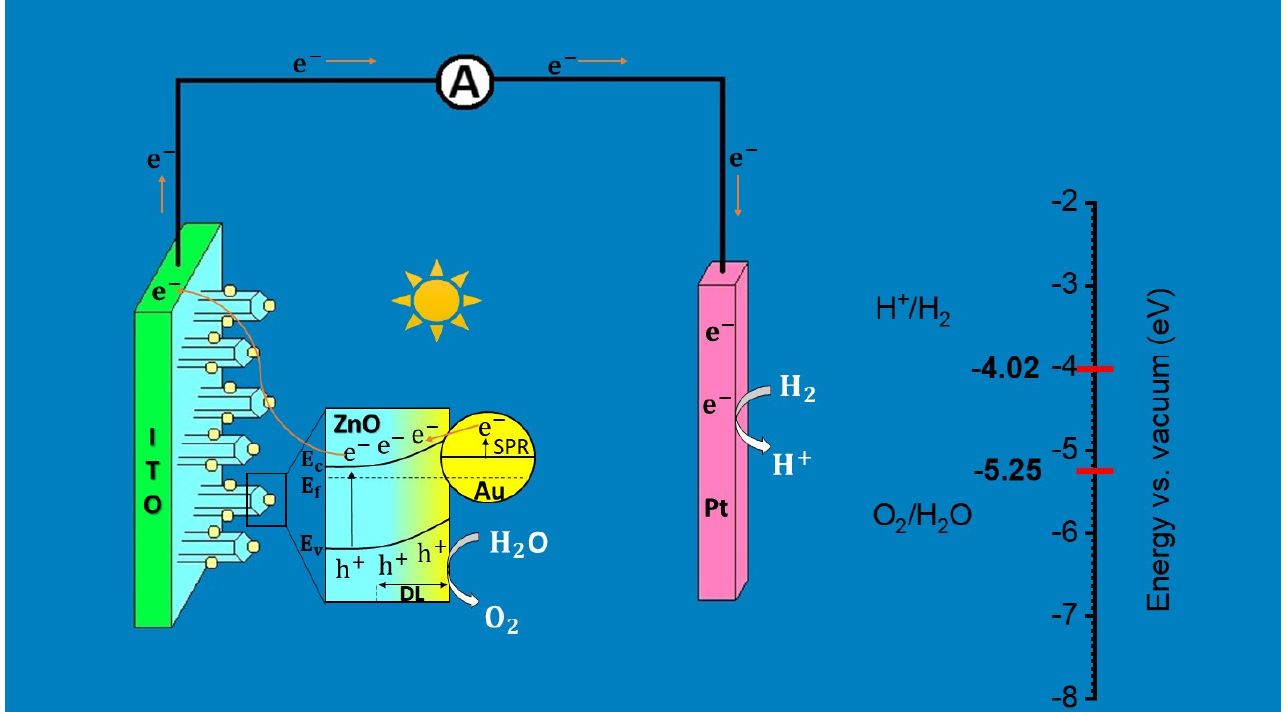
Figure 9. Schematic diagram of photoelectrochemical water splitting process via grad-Au/ZnO.